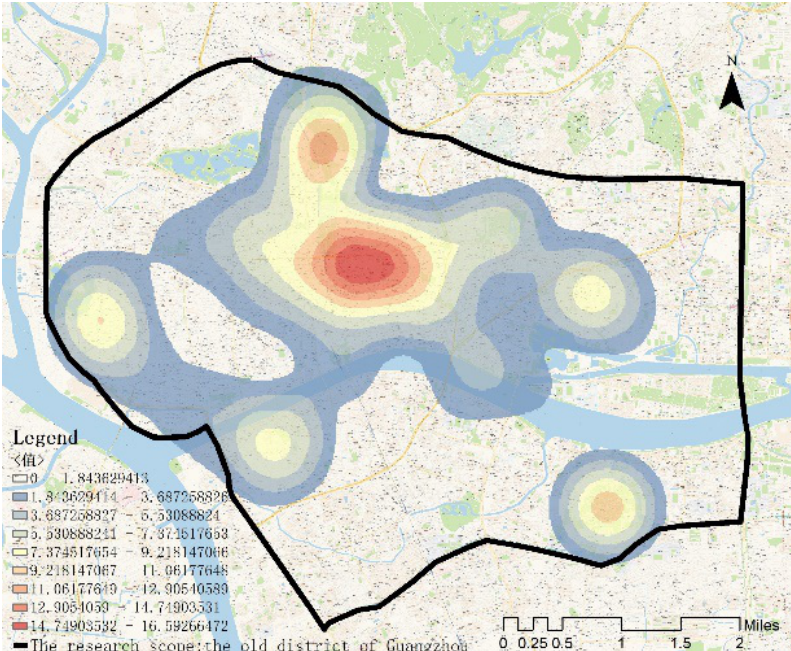
Fig. 31 Kernel density distribution of historic